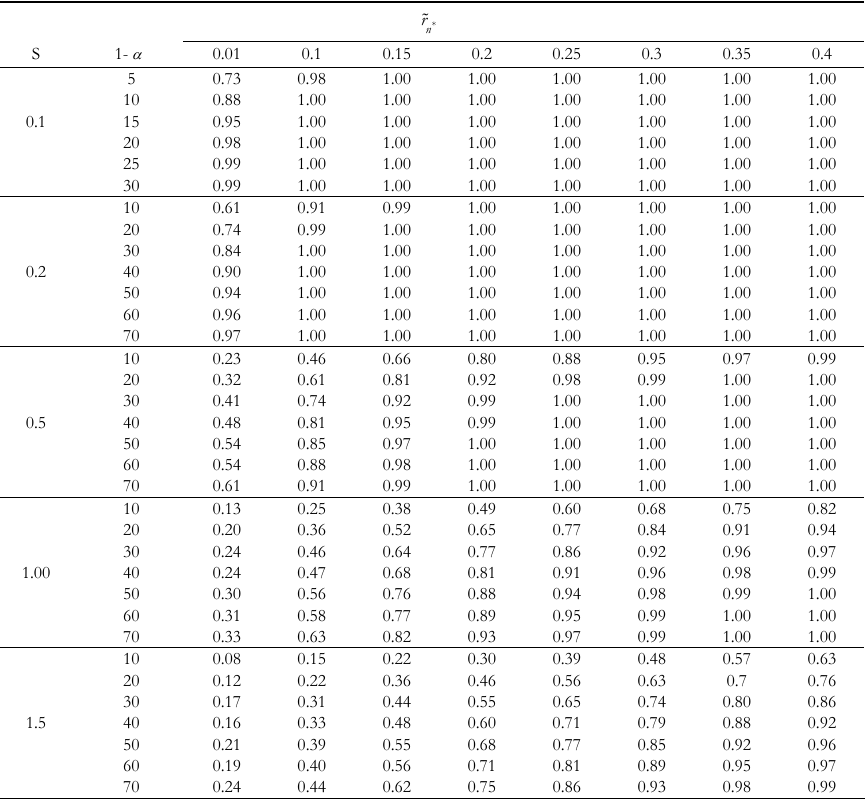
Coverage proportions * p for the bootstrap distribution of the sample mean, by fixed error and standard